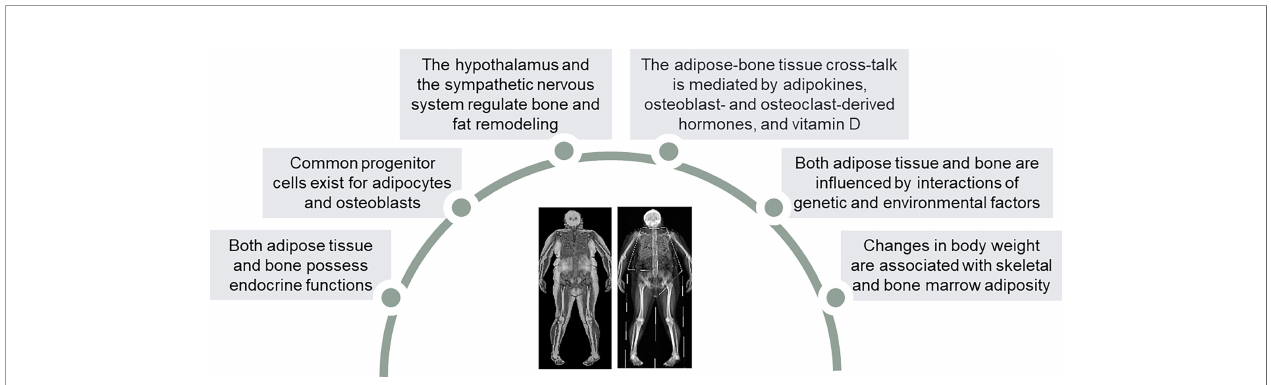
FIGURE 1 | Similarities and homologies between adipose tissue and